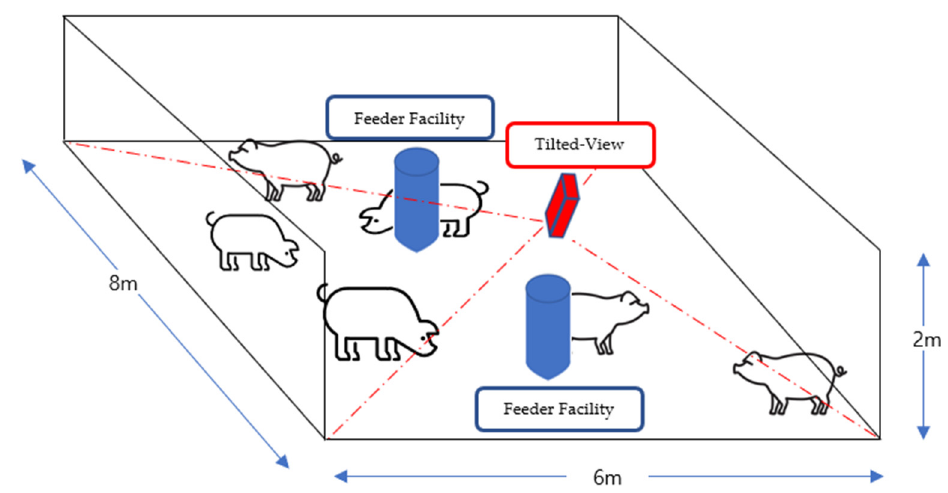
Figure 9. Experimental setup with a tilted-view surveillance camera (shown as red color) to cover a pig pen with feeder facility (shown as blue color).